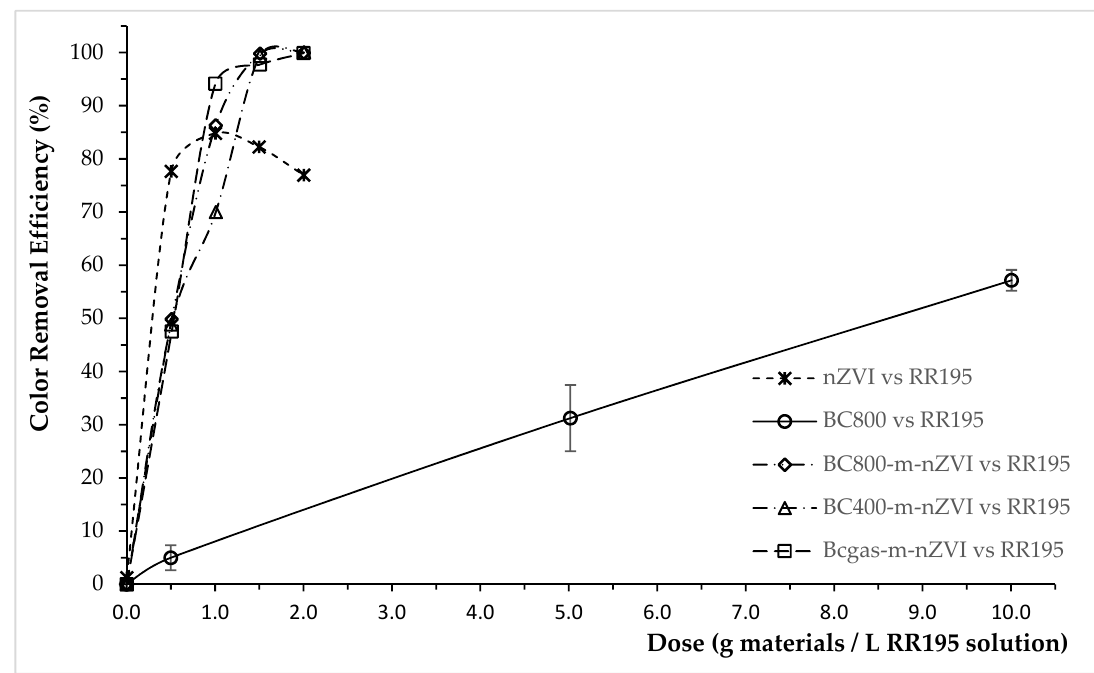
Figure 7. Color removal efficiency of the original materials of nano zero valent iron (nZVI) and 800 °C—pyrolyzed rice husk biochar (BC800), and the modified materials of magnetic-nZVI gasified rice husk biochar (BCgas-m-nZVI), magnetic-nZVI 400 °C—pyrolyzed rice husk biochar (BC400-m-nZVI), and magnetic-nZVI 800 °C—pyrolyzed rice husk biochar (BC800-m-nZVI) for reactive red dye (RR195) in dyeing solution.